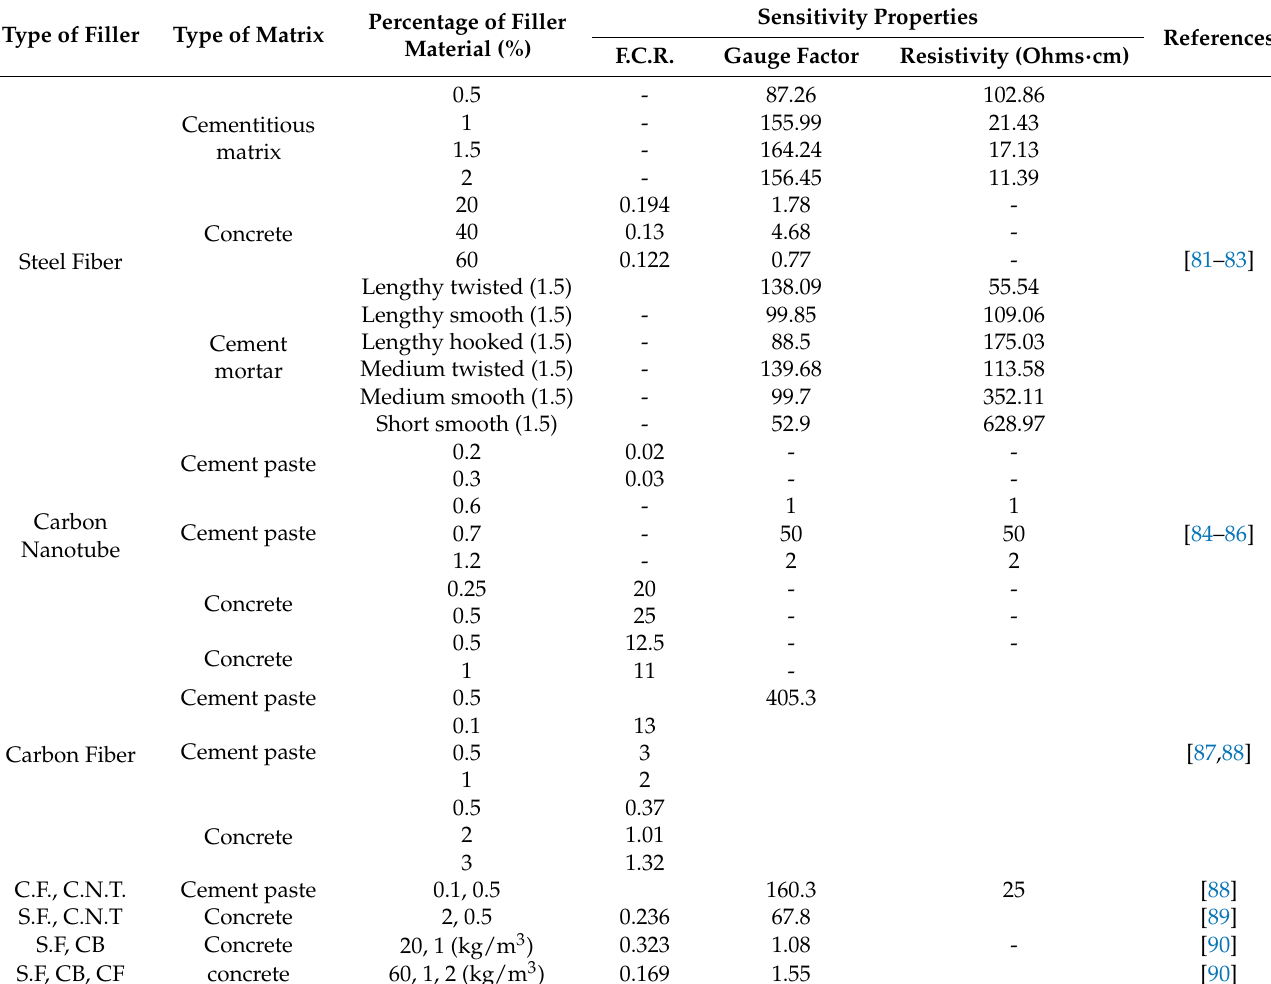
Table 9. Sensing parameters for different fibre